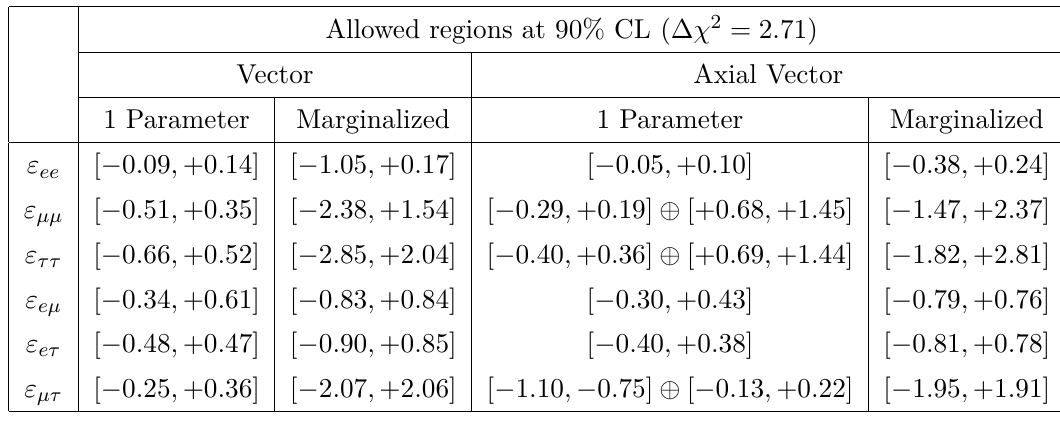
Table 2 . 90% CL bounds (1 d.o.f., 2-sided) on the coefficients of NSI operators with electrons, for the vector ( ε V ) and axial vector ( ε A ) scenarios. Results are provided separately for two cases: when only one NSI operator is included at a time (“1 Parameter”) or when the remaining NSI coefficients are allowed to float freely in the fit